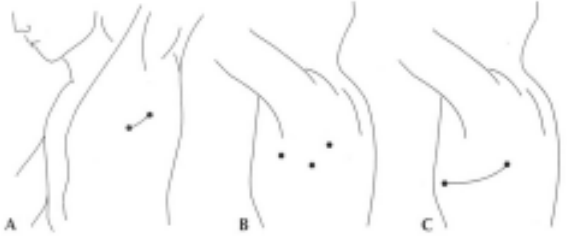
Fig 2 - Design explaining the progressive reduction of thoracotomy with different surgical techniques. A) Transaxillary technique; B) Video-assisted thoracoscopic surgery; C) conventional lateral